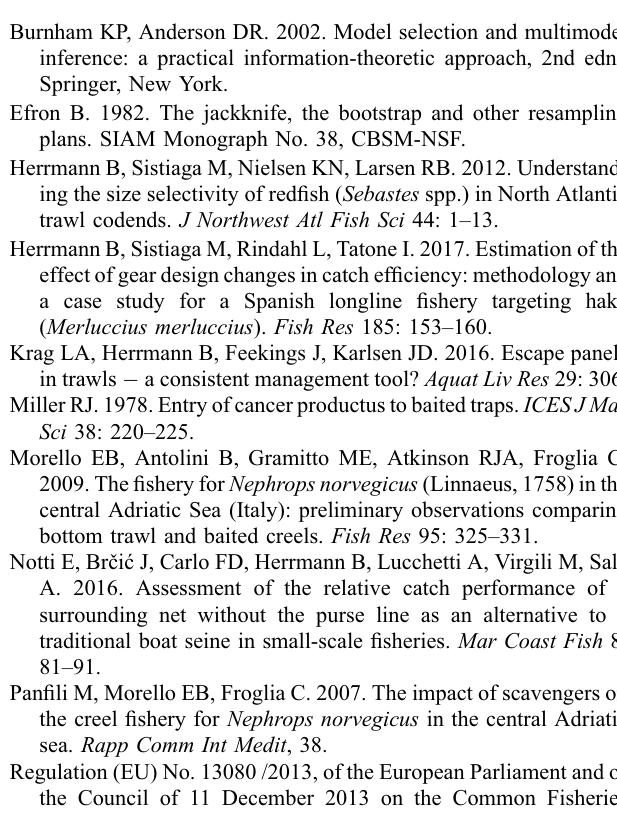
Fig. A1. Residuals of the model fi ts for all species. NEP: Norway lobster; MTS: mantis shrimp; IOD: blue-leg swimming crab; POD: Poor cod; SPFX: Blotched picarel. Pooled: based on the pooled female and male